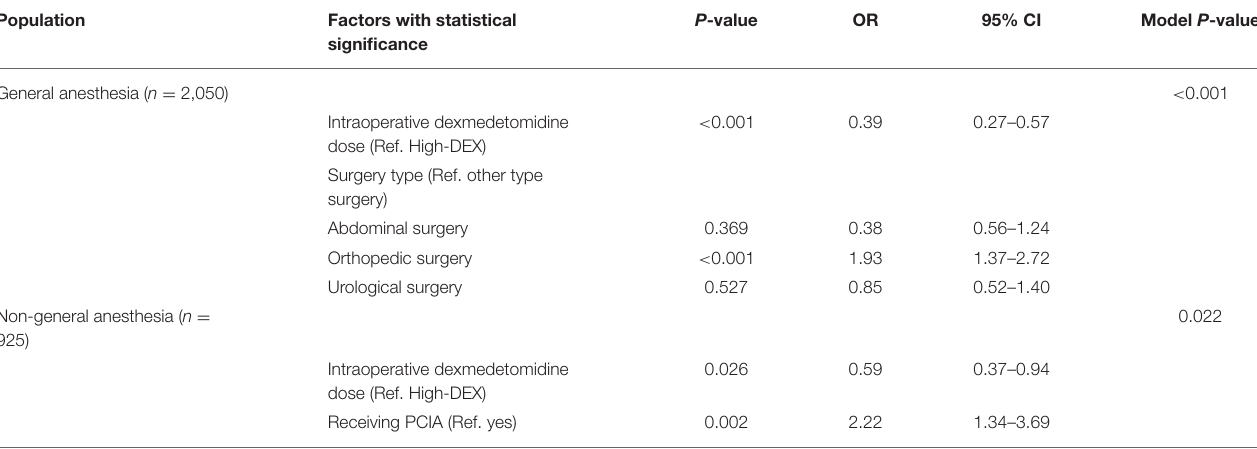
TABLE 4 | Risk factors for severe sleep disturbance among patients who received dexmedetomidine therapy under general anesthesia and non-general anesthesia in a stepwise logistic regression analysis model. P -value OR 95% CI Model P -value Population Factors with statistical significance General anesthesia ( n =